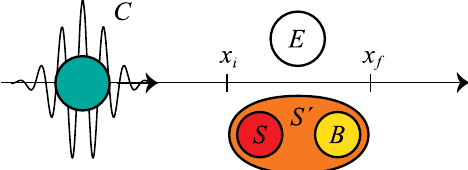
FIG. 6. A control particle. One way to “ quantize ” the control parameter x of the classical Crooks relation would be to regard it as the position of a quantum particle. The propagation of the particle would approximately implement the time-dependent Hamiltonian for suitable wave packets. A particularly clean example is obtained if E and S 0 only interact when the control ; x particle is in an “ interaction region ” ½ x (cf. the construction i f (cid:2) in Ref. [116]). Since the global Hamiltonian contains interactions between E and S 0 , it does not fit with our previous classes of models, and in particular, it does not satisfy the factorization property (30). However, for suitable choices of measurement operators Q i þ and Q f þ that are localized outside the interaction C C region, the systems becomes approximately noninteracting, and the factorization property (30) is approximately satisfied. This makes it possible to derive an approximate conditional fluc- tuation relation on the energy